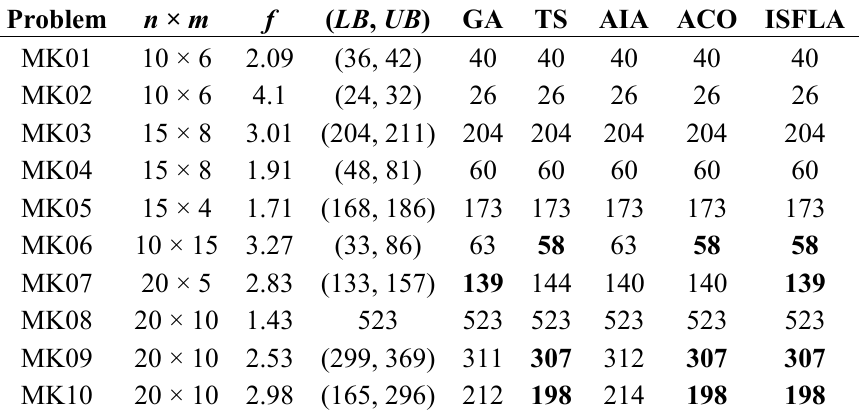
Table 1. Performance comparison between improved shuffled frog-leaping algorithm (ISFLA) and other algorithms. The numbers in bold are the best among the five approaches. TS, tabu search; AIA, artificial immune